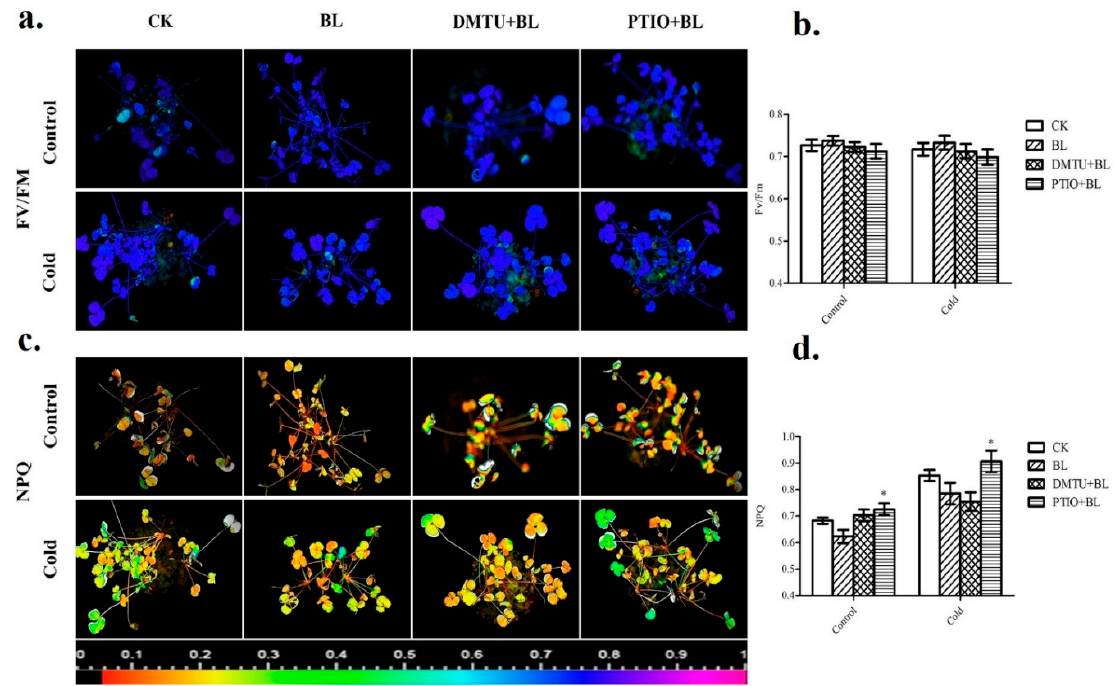
Figure 6. Chlorophyll fluorescence parameters were determined with an imaging PAM (IMAG-MAXI; HeinzWalz). Images and values of the F V / F M ( a , b ) and NPQ ( c , d ) in various treatments. The false color code depicted at the bottom of the image ranged from 0 (black) to 1.0 (purple). All the leaf samples were collected at the same time every day. Bars represent mean and standard deviation of values obtained from three biological replicates. Significant differences ( p < 0.05) are denoted by asterisks.